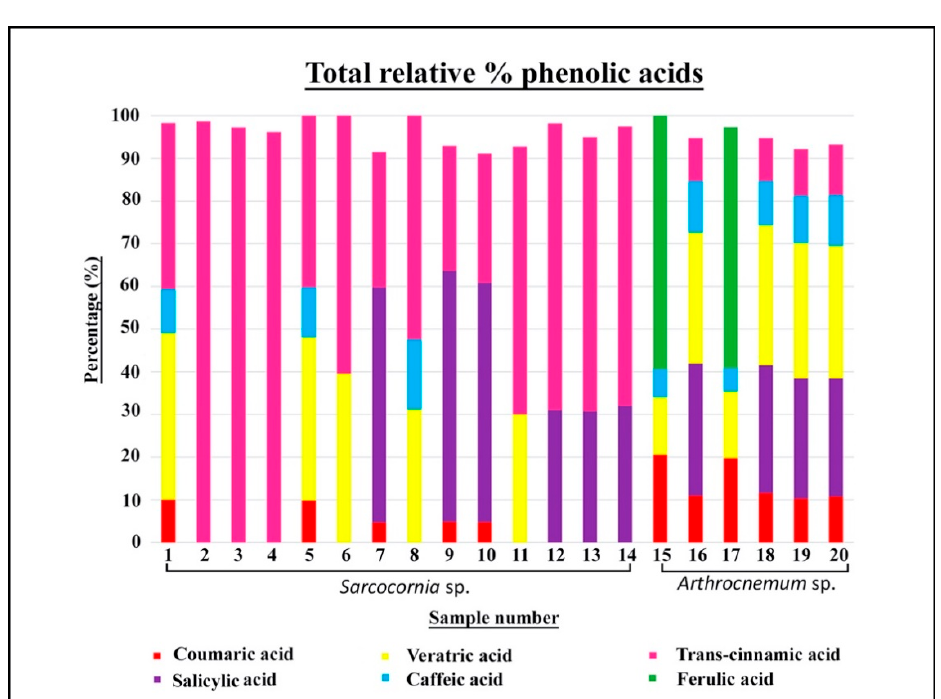
Figure 1. Total relative percentages of the phenolic acids.